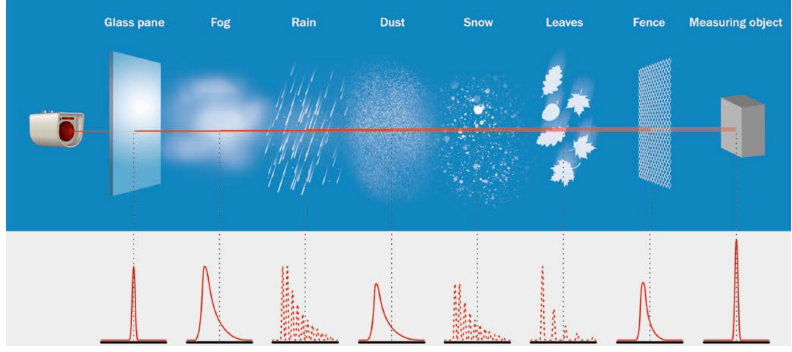
Figure 3. Schematic FWF signal in DVE, Copyright © SICK